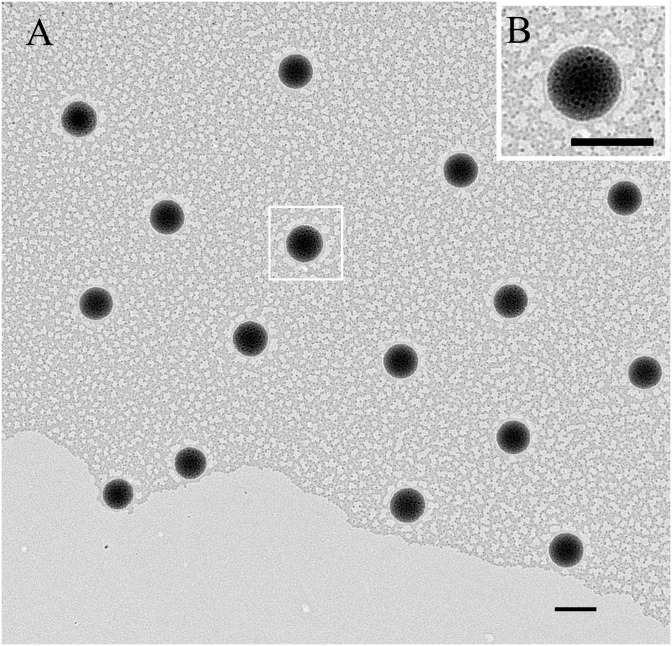
TEM micrographs of sex pheromone-loaded MPEG5000-PCL2000 nanoparticles.Bars in panel A and panel B are 400 nm. Panel B is an enlarged view of the boxed area in Panel A.